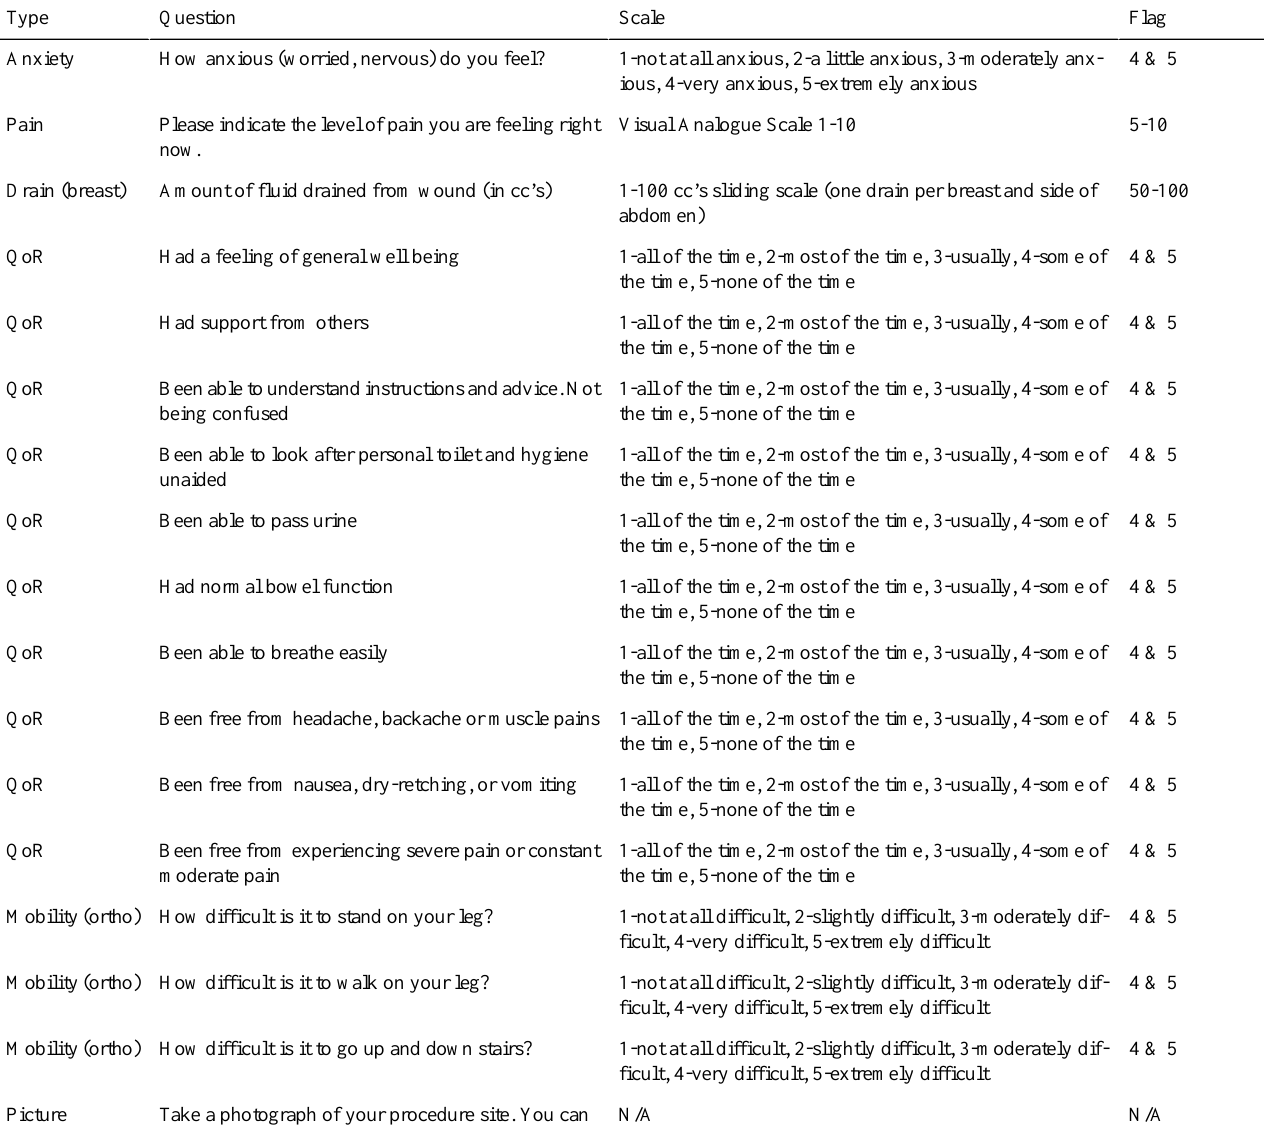
Table 1. List of indicators on the mobile device. FlagScaleQuestionType anxiousHow anxious (worried, nervous) do you feel?Anxiety